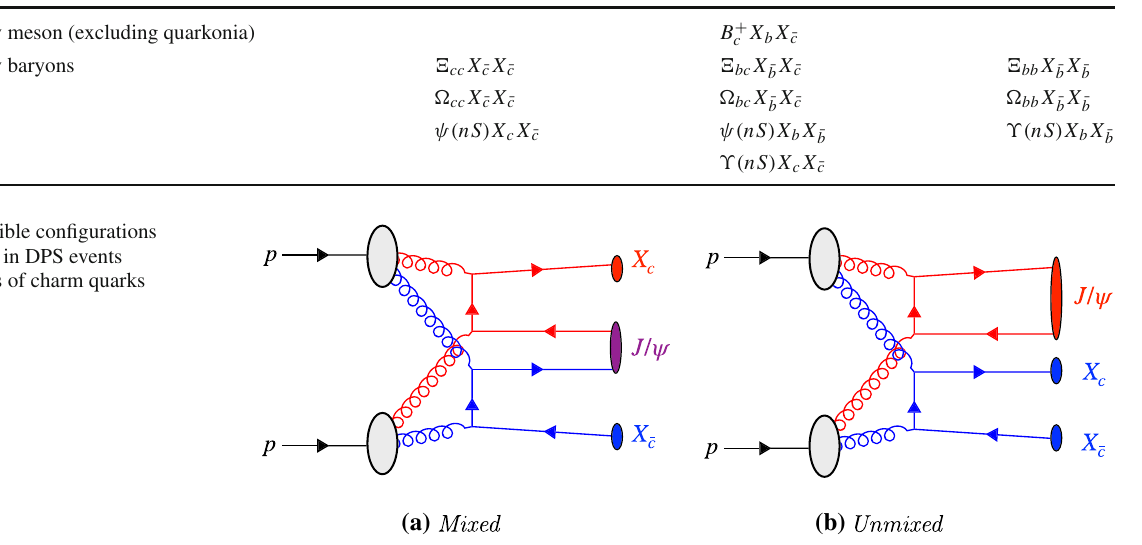
figurations. To ensure an unambiguous association between the heavy quarks, only events with a total of one B + one X ¯ c hadron and one X b hadron are